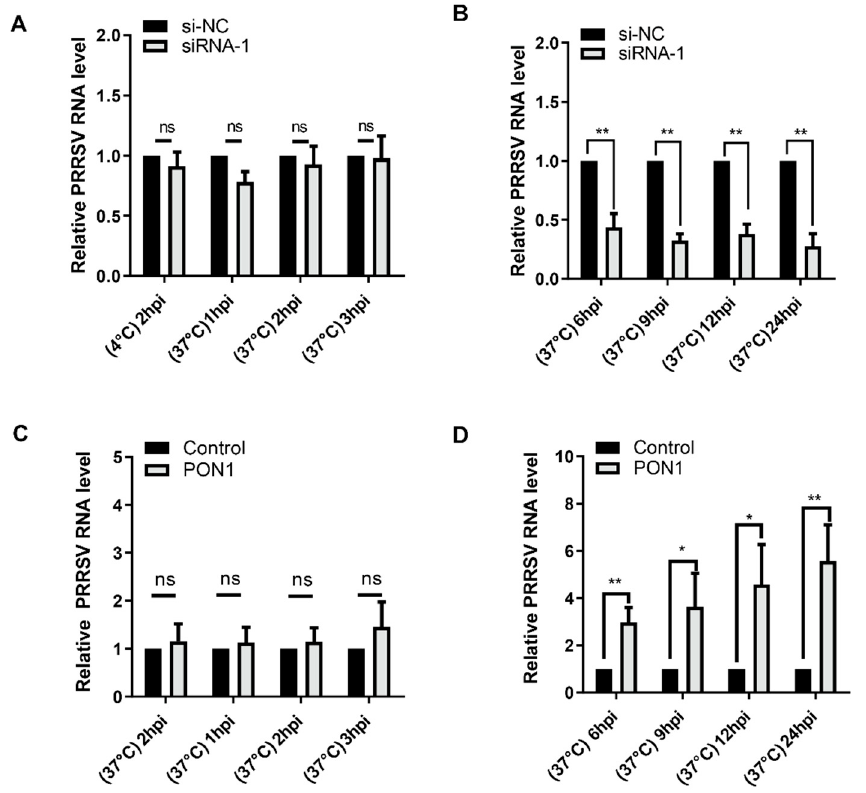
Figure 3. PON1 facilitates PRRSV proliferation at the stage of replication. ( A ) The depletion of endogenous PON1 does not affect virus attachment and entry. PAMs were transfected with siRNA-1 for 24 h, incubated with PRRSV at 4 ◦ C for 2 h, and then incubated at 37 ◦ C for 1 h to 3 h; then, virus RNA levels were determined by qPCR. ( B ) The depletion of endogenous PON1 decreases PRRSV replication. After PON1 was knocked down, PAMs were infected with PRRSV at 37 ◦ C for 6 to 24 h. ( C ) Overexpression of PON1 does not affect virus attachment and entry. PAMs were overexpressed PON1 for 24 h and then infected with PRRSV at 4 ◦ C for 2 h and 37 ◦ C for 1 to 3 h.The levels of viral RNA were determined by qPCR. ( D ) The overexpression of PON1 increases PRRSV replication. After the overexpression of PON1, the PAMs were exposed to PRRSV incubated at 37 ◦ C for 6 h to 24 h. The virus RNA levels were determined by qPCR. Data are presented as the mean ± SD. ns, p > 0.05; *, p < 0.05; **, p < 0.01. The p value was calculated using a Student’s t -test